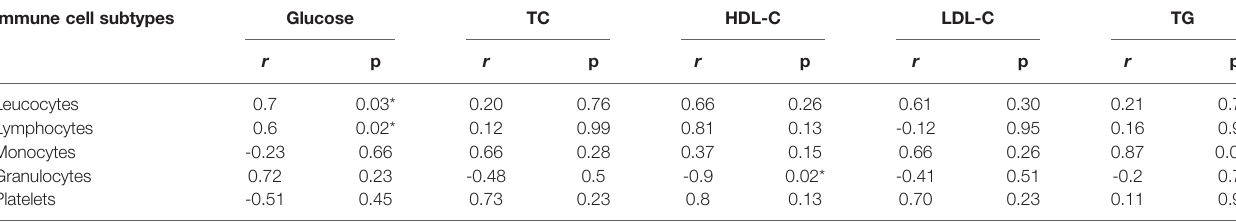
TABLE 4 | Correlations between immune cell subpopulations and biochemical parameters in women with GDM (n = 25). Immune cell subtypes